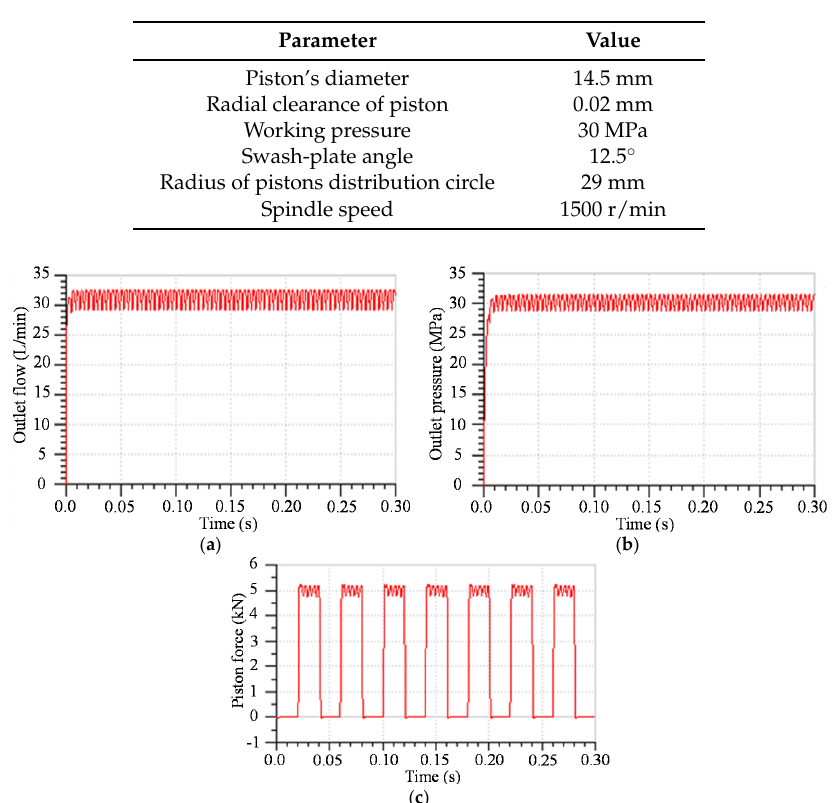
Figure 5. Results of co ‐ simulation: ( a ) Outlet flow; ( b ) Outlet pressure; ( c ) Piston force.